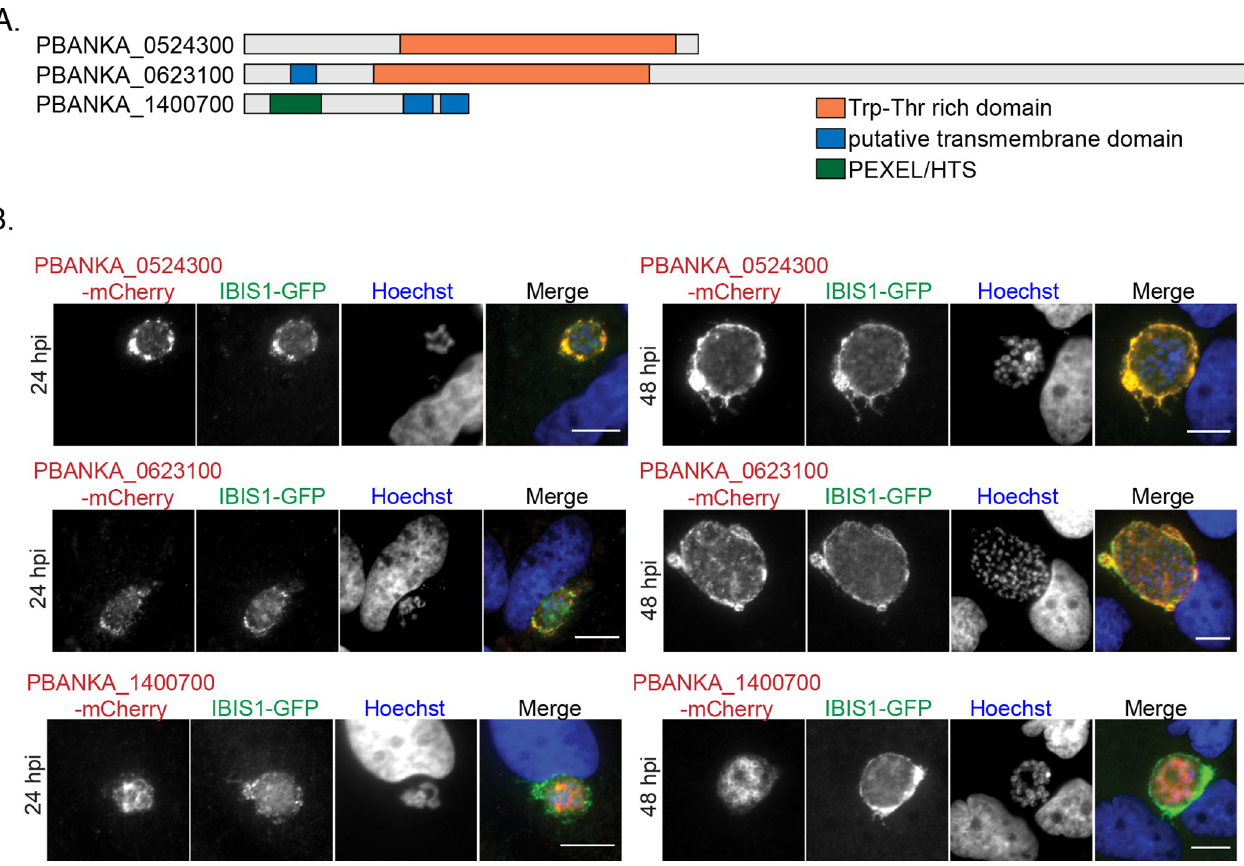
Fig 2. mCherry tagged PBANKA_0524300 (IPIS2), PBANKA_0623100 (IPIS3) colocalize with IBIS1-GFP at the liver-stage parasitophorous vacuole. A) Protein features of candidate proteins that coprecipitated with IBIS1. B) Hepatoma cells were infected with sporozoites after the cross-fertilization of IBIS1-GFP and either PBANKA_0524300-mCherry, PBANKA_0623100-mCherry or PBANKA_1400700-mCherry transgenic parasite lines. Cells were fixed at indicated time points and the mCherry and GFP signals were amplified by using anti-RFP and anti-GFP antibodies. Scale bars, 10 μ m.